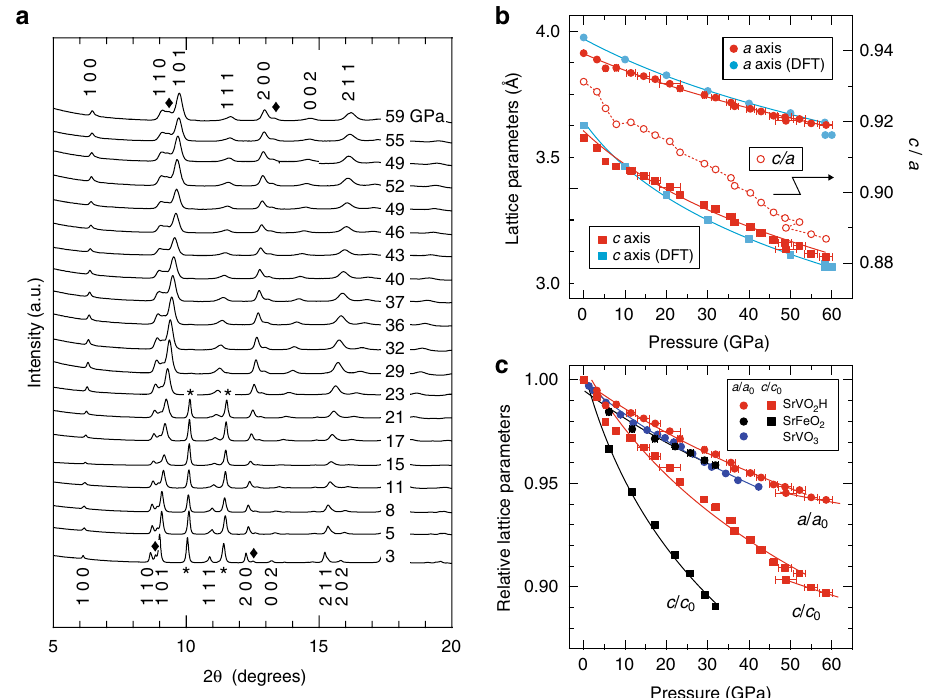
Fig. 2 High-pressure behavior of SrVO 2 H and SrFeO 2 . a Powder synchrotron XRD patterns of SrVO 2 H (sample SrVO 2 H-A) under various pressures at room temperature. All the patterns are indexed on the basis of a tetragonal unit cell. The fi lled diamond and asterisk symbols correspond to SrVO 3 and rhenium from the gasket, respectively. b Pressure dependence of lattice parameters for the experimental (red) and the DFT-computed (sky blue) values of SrVO 2 H – note that some error bars are smaller than the width of the symbols. The decrease in pressure from 52 GPa to 49 GPa as the cell volume decreases suggests a phase transition to a denser phase. c Relative lattice parameters, a / a 0 and c / c 0 , of SrVO 2 H (red), SrFeO 2 (black), and SrVO 3 (dark blue) as a function of pressure. Circles and squares correspond to the a and c axes, respectively. Solid lines in b and c represent linearized Birch-Murnaghan fi ts to the data